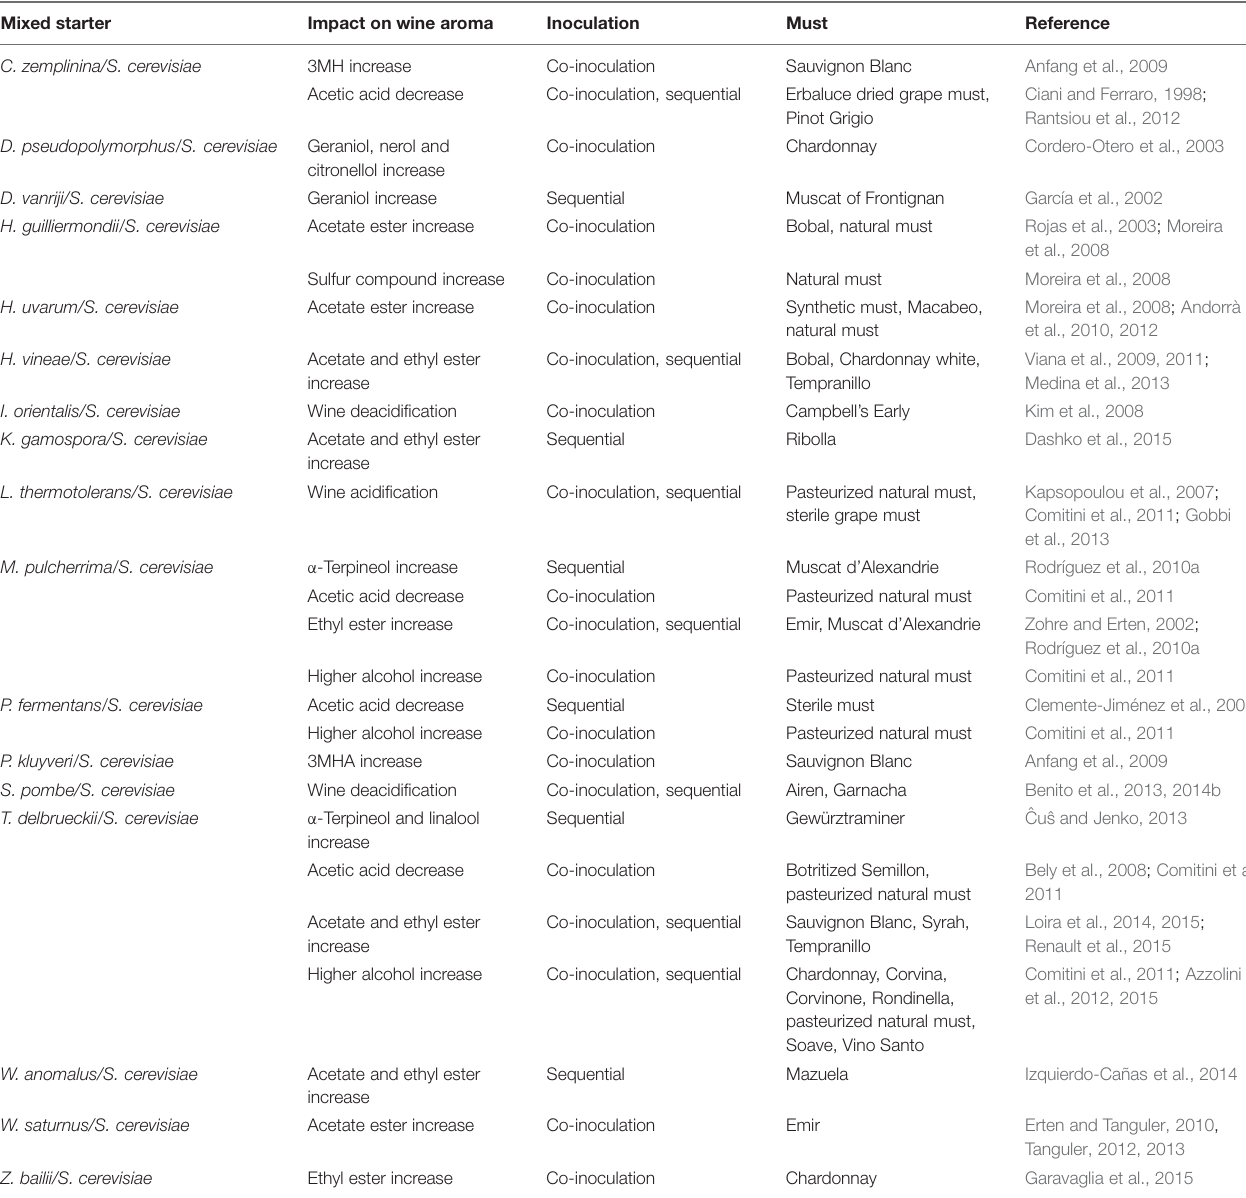
TABLE 3 | Mixed starters designed to improve primary and secondary wine